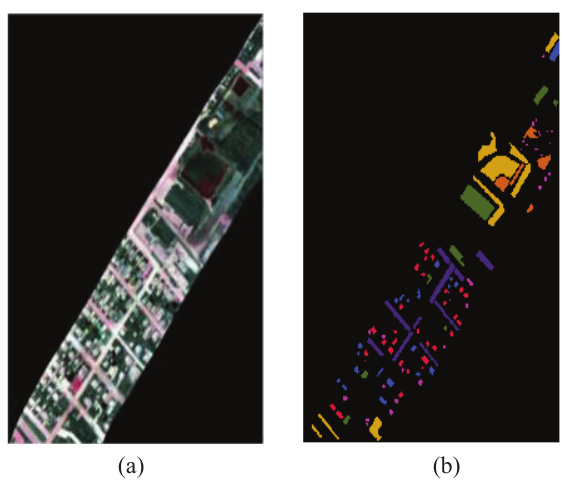
Figure 7. The Grss_dfc_2014 data set. ( a ) A false color map. ( b ) The ground truth map.